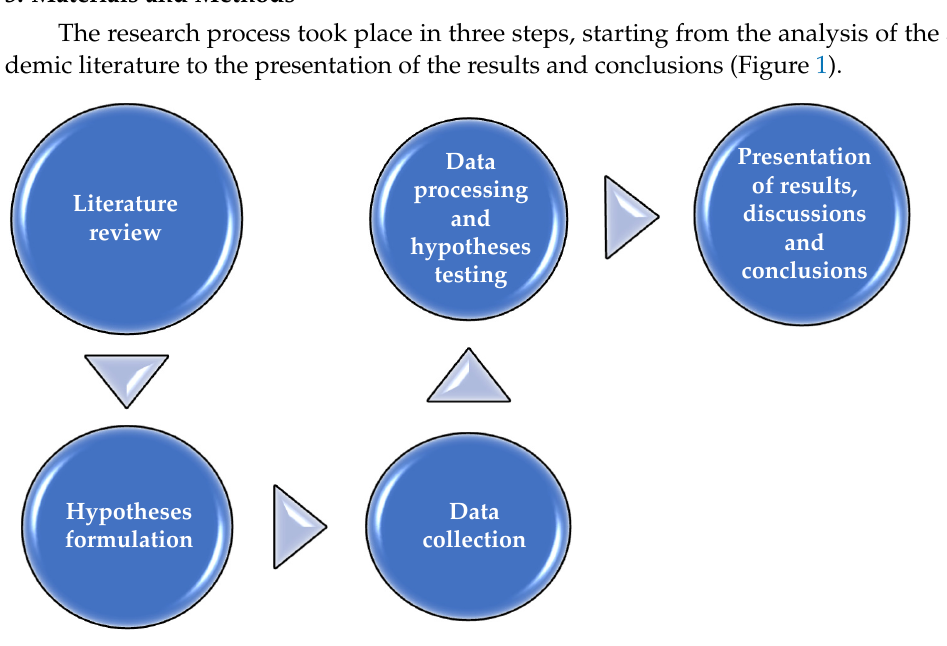
Figure 1. Research steps. Source: the authors’ design.